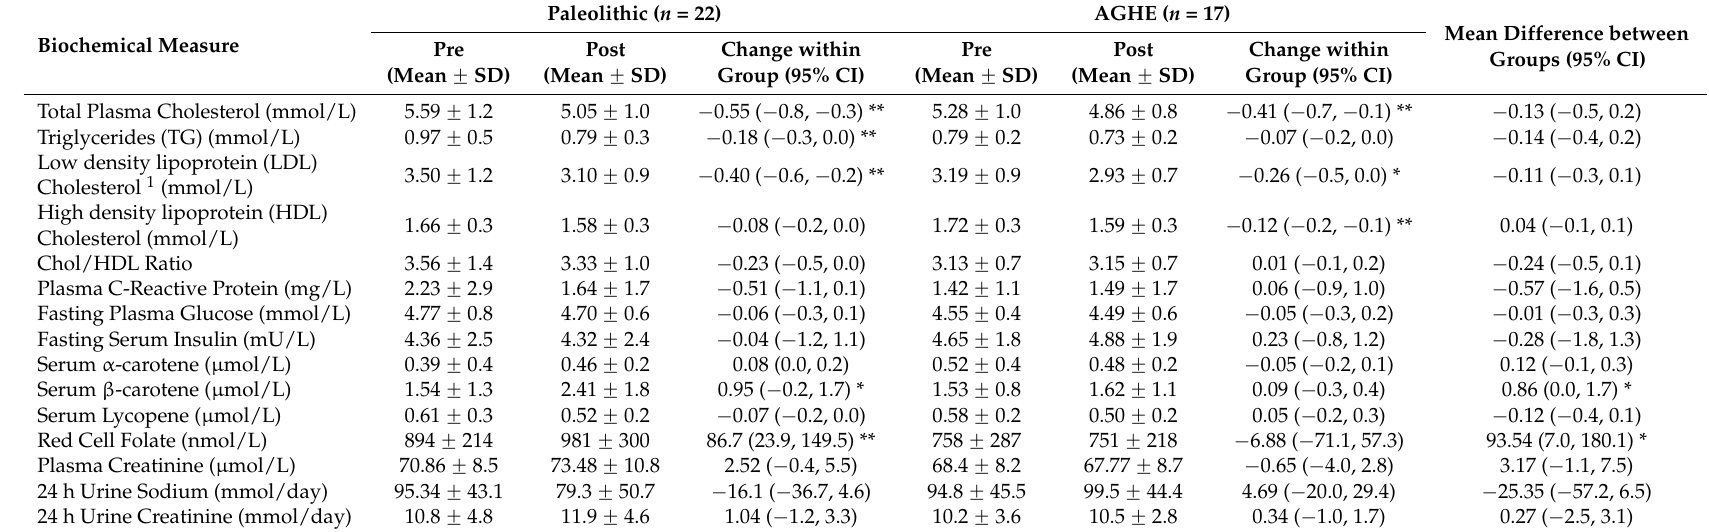
Table 2. Mean pre and post biochemistry, showing mean changes within and between groups 1